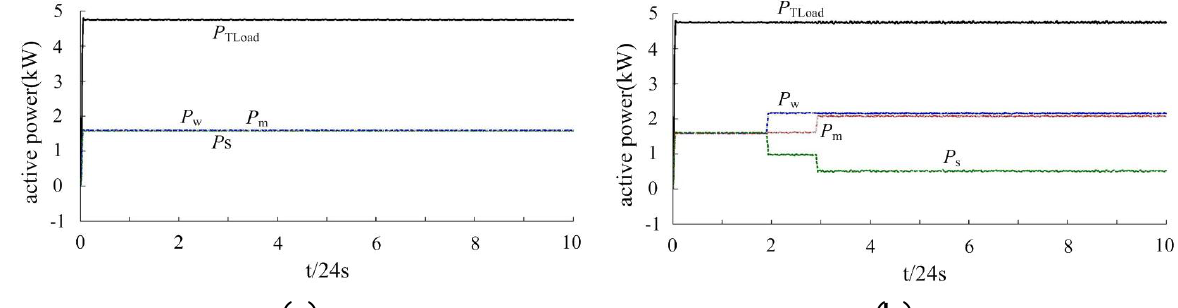
Figure 10. Output power of wind/solar/micro gas turbine DES. ( a ) Average allocation of load power; ( b ) Coordinated allocation of load